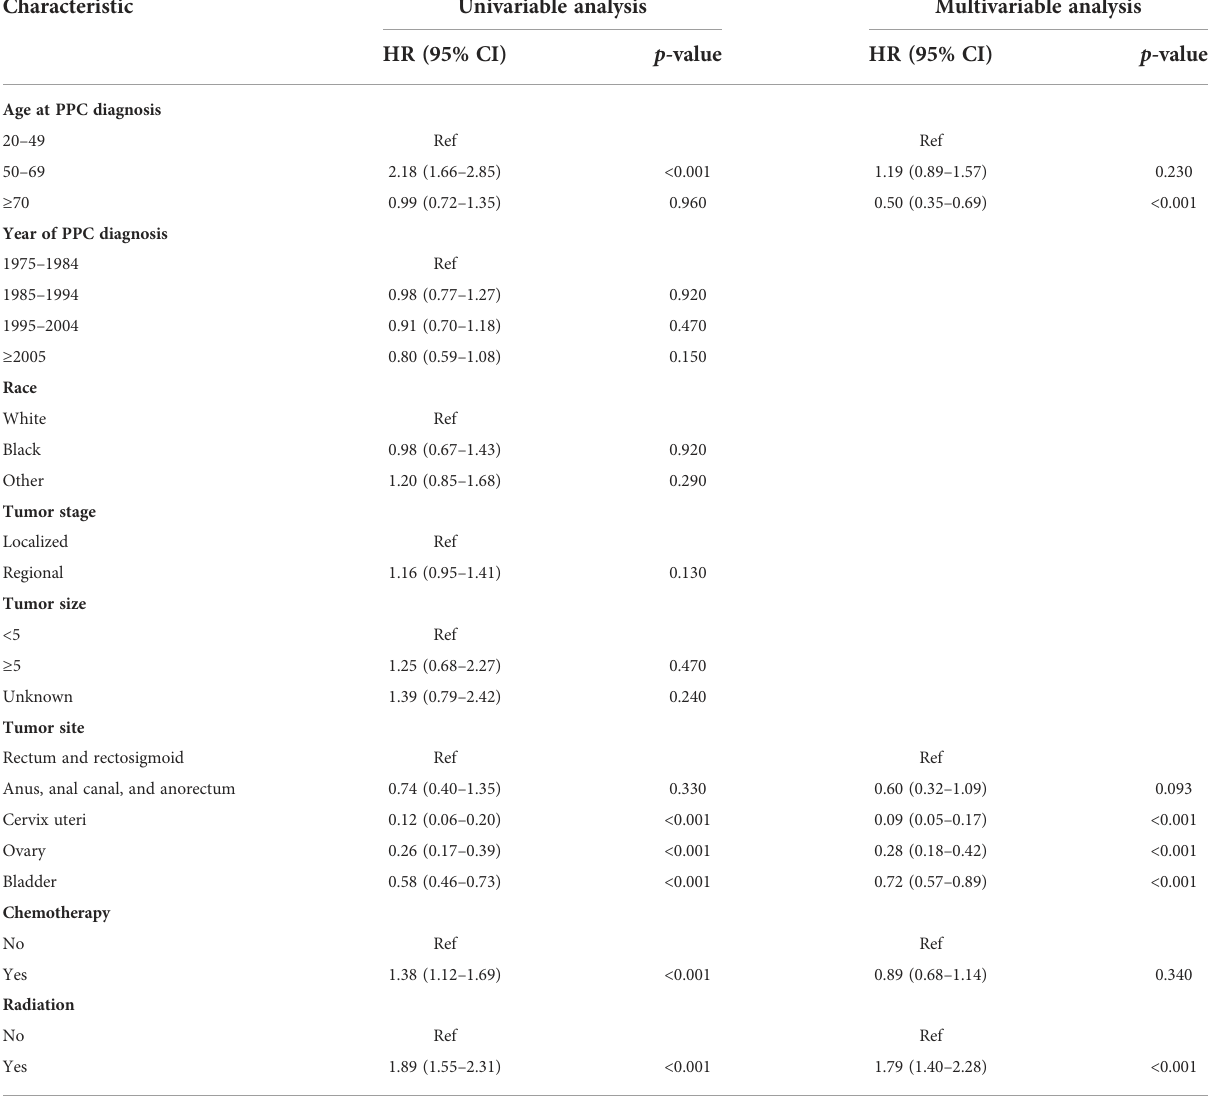
TABLE 2 Univariable and multivariable competing risk regression analyses of risk of developing SCUC in PPC